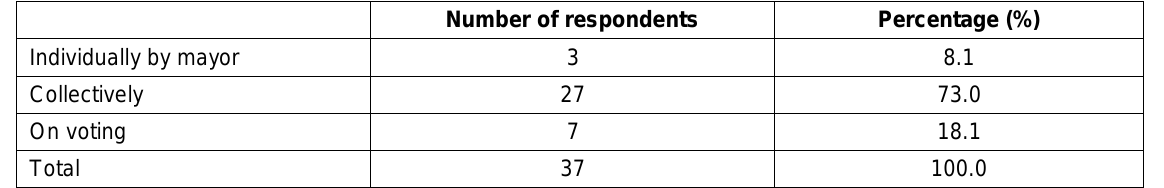
Table 8: Views on how SCC decisions are made (general